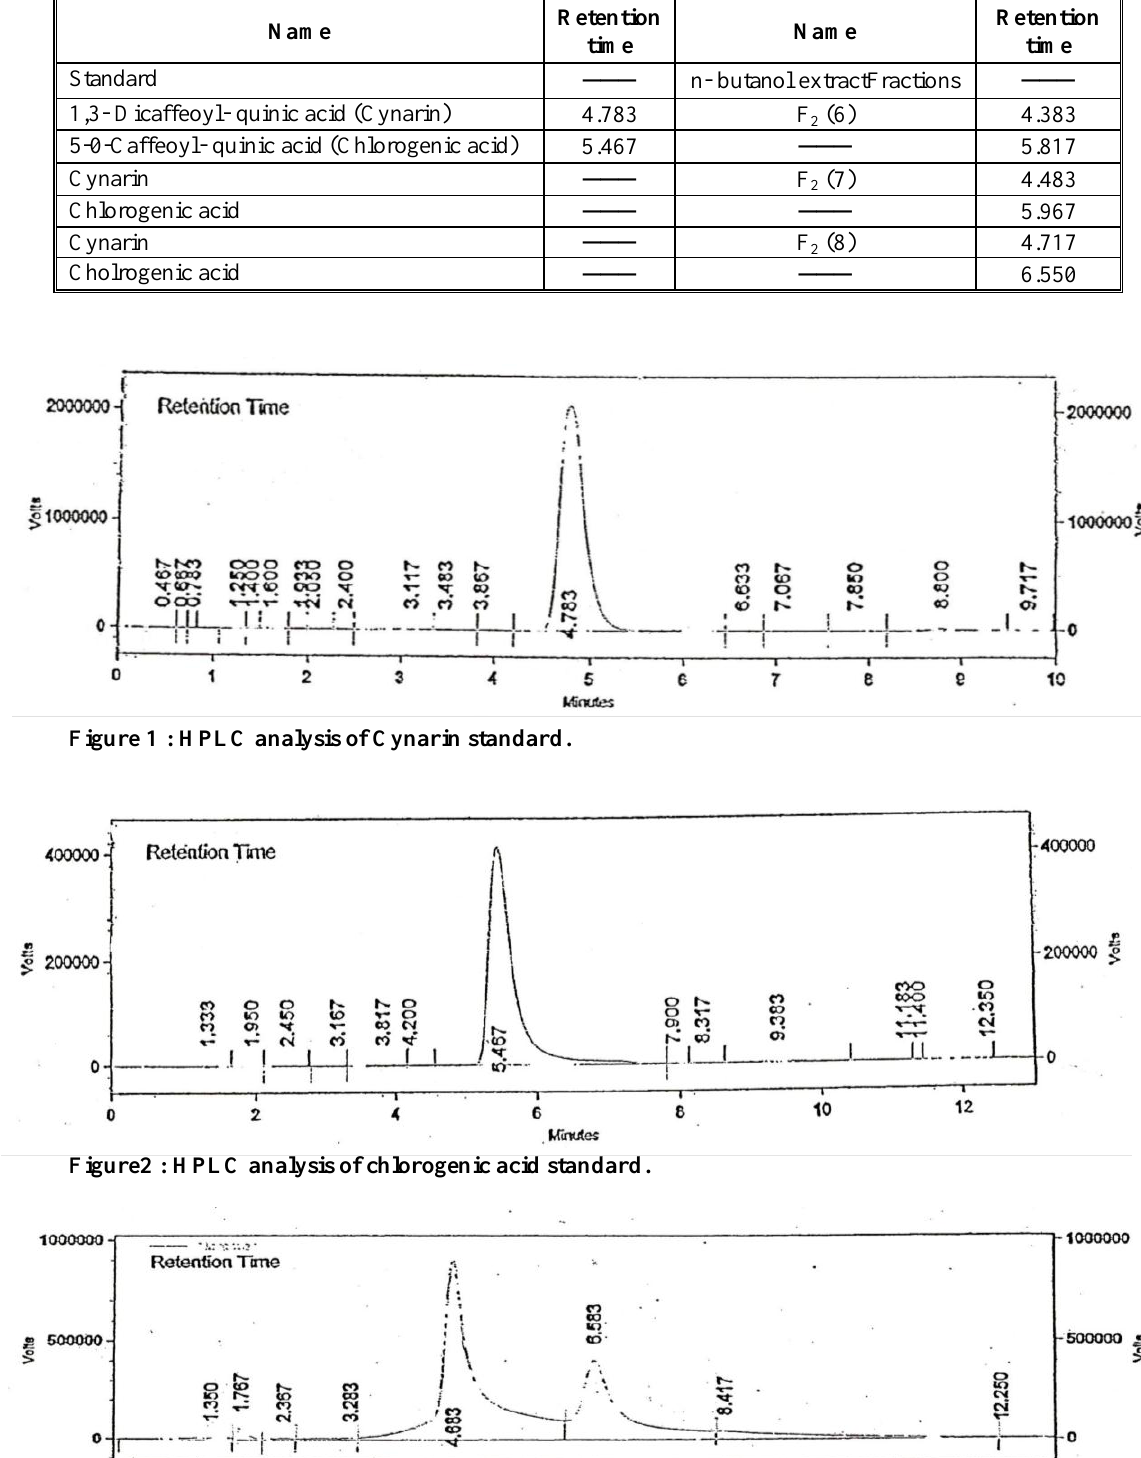
Table 5: Comparison of retention times of standard phenolic acid with those of the plant n- butanol extracts after separation in HPLC.